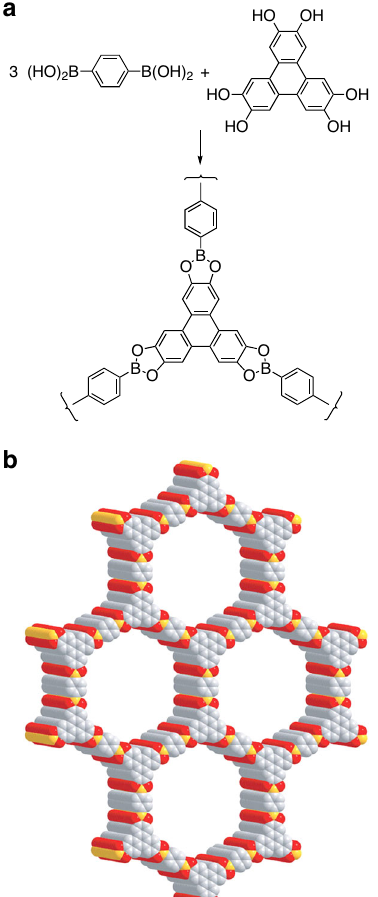
Fig. 4 Structure of COF-5. a Condensation of 1,4-benzenediboronic acid with 2,3,6,7,10,11-hexahydroxytriphenylene to form COF-5. b Model of the graphitic structure of COF-5 based on PXRD, with atoms of carbon shown in gray, boron in yellow, and oxygen in red. Atoms of hydrogen are omitted for clarity. Adapted with permission from the American Association for the Advancement of Science (AAAS), ref. 48